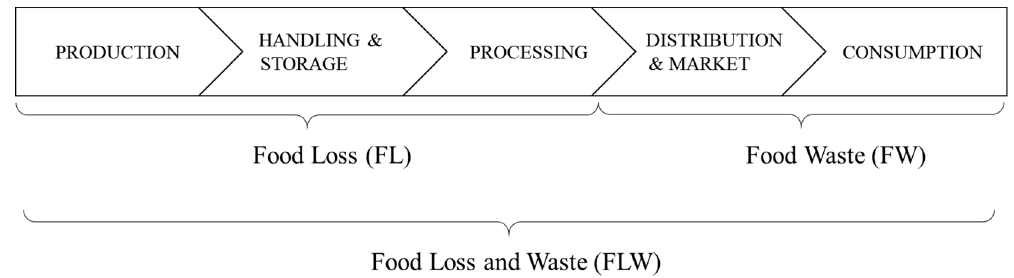
Figure 1. Framework of Food Loss and Waste (FLW) definitions.